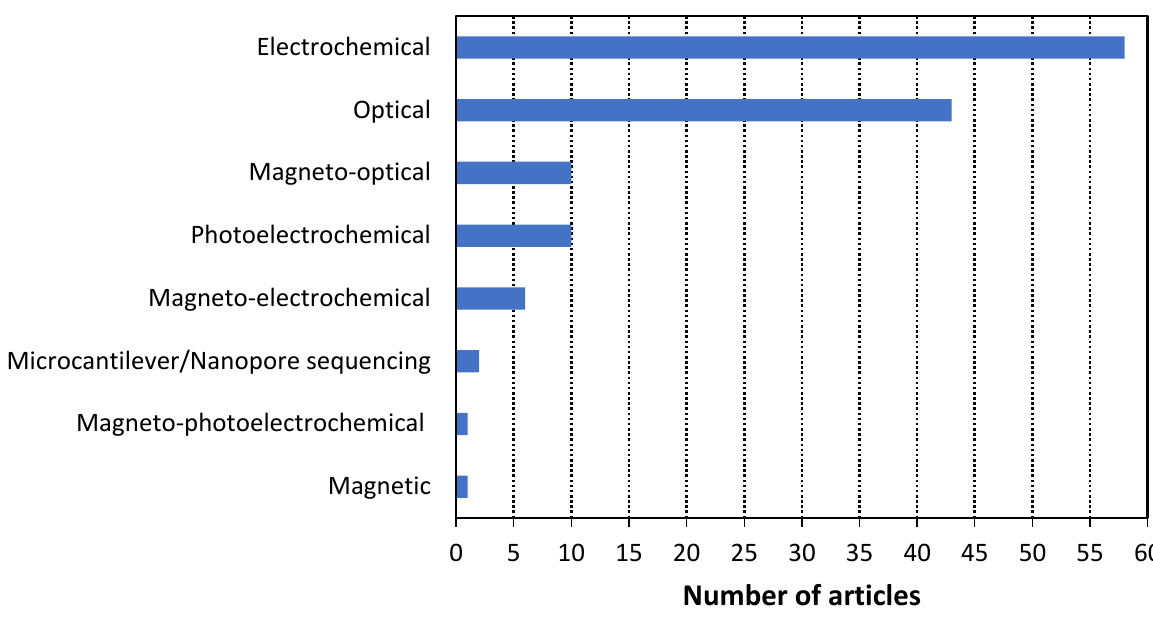
Figure 10. Histogram of the articles of the three biorecognition technologies by type of cancer.